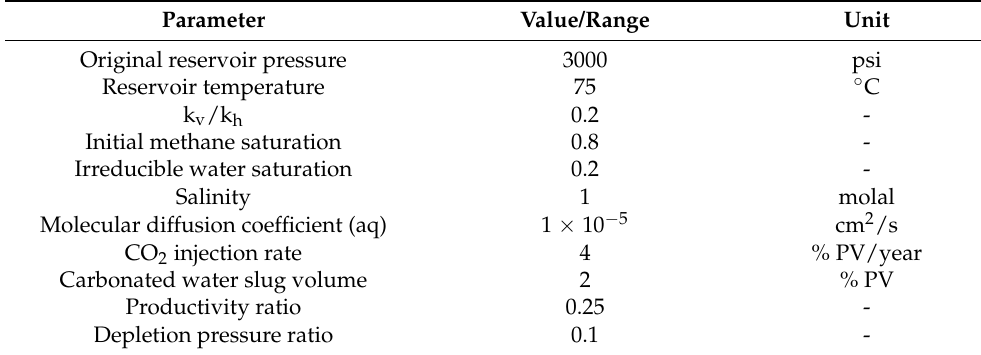
Table A3. Reservoir and operational parameters for the 3D sector.